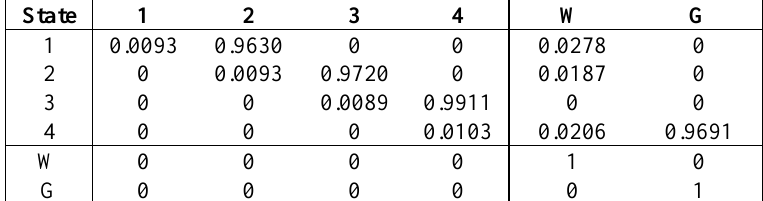
Table 6. The initial transition probability matrix